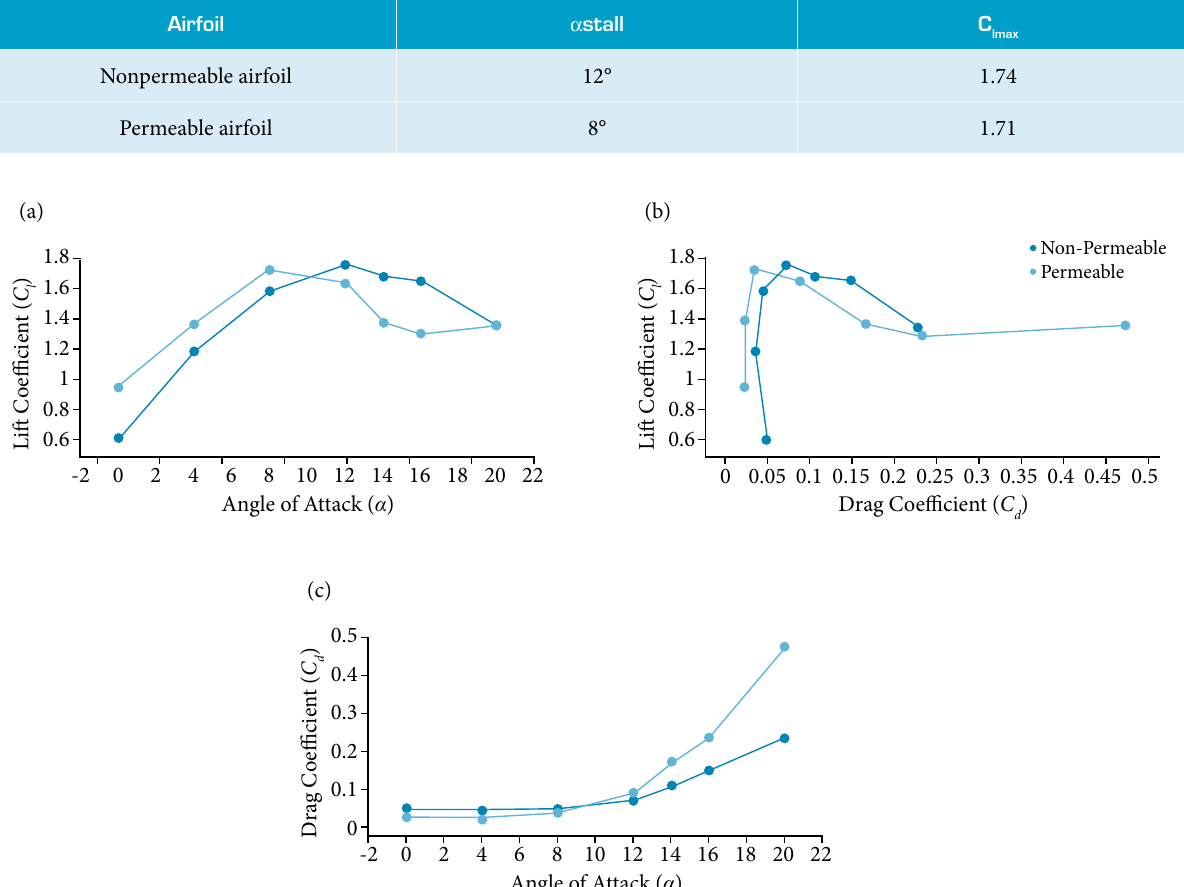
Table 5. C at α stall for a permeable and nonpermeable eagle’s airfoil. lmax